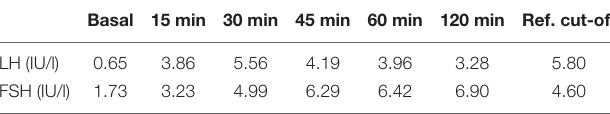
TABLE 2 | Result of a GnRH infusion test in the index case.